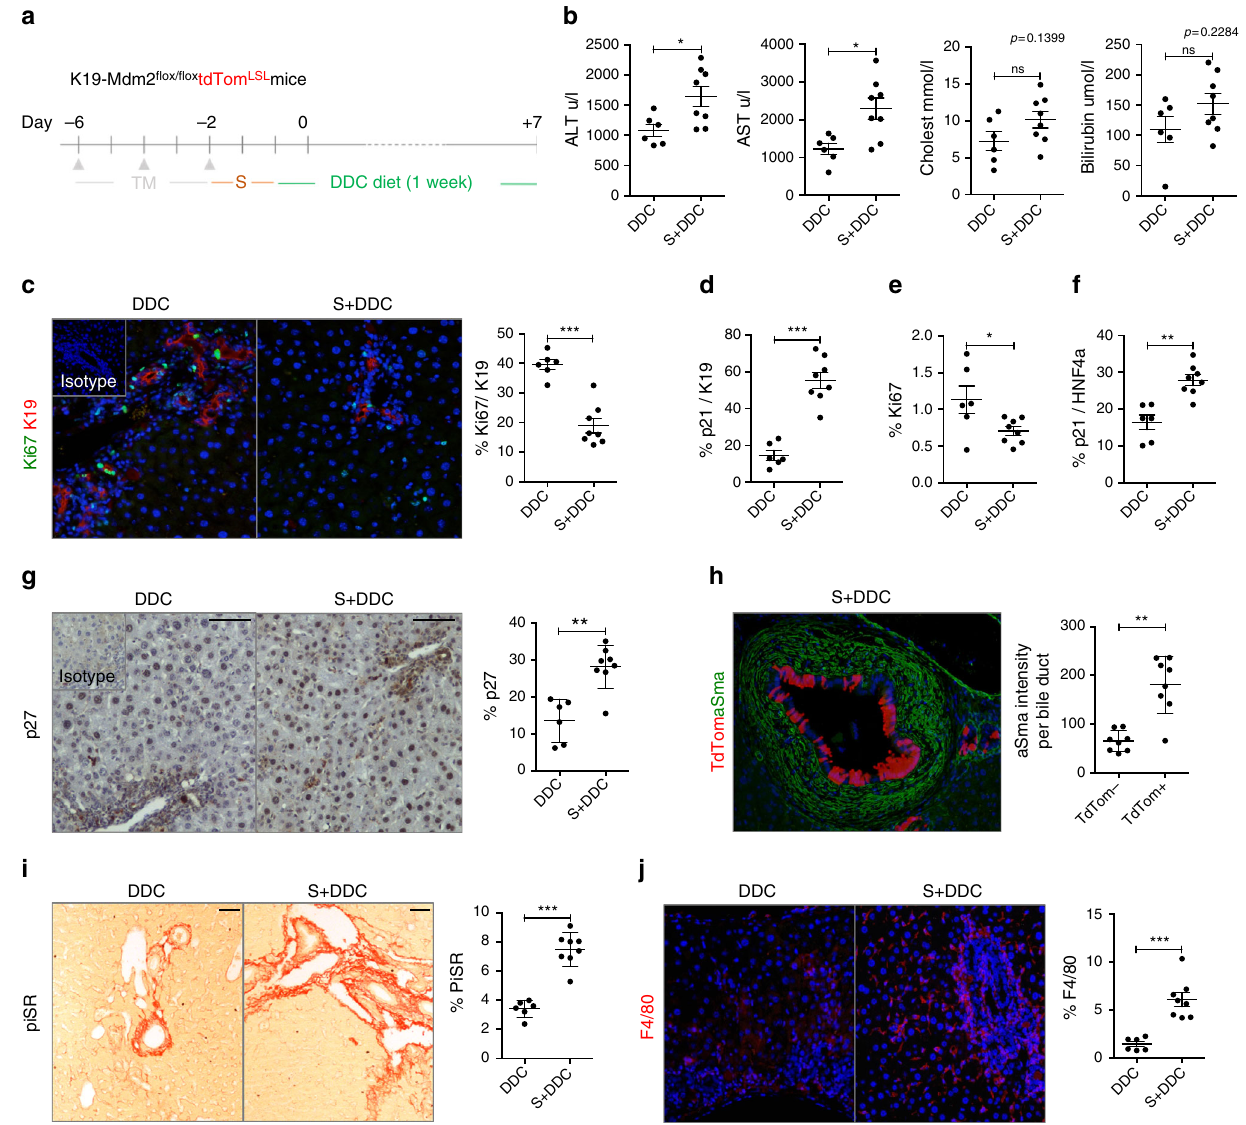
Fig. 4 Cellular senescence in cholangiocytes aggravates biliary injury. a Schematic representation of the experiment. Two days after the induction of the model the DDC diet was administered for 1 week. Experimental groups include: DDC diet control group (DDC, where mice are administered with oil, N = 6) and Senescence + DDC diet (S + DDC, where animals receive tamoxifen, N = 8). b Serum analysis shows increased liver damage in the presence of senescent cholangiocytes. c Ki67-proliferating (green) cholangiocytes (red) decrease in the S + DDC group. d Increased number of p21-positive cholangiocytes in the S + DDC group. e Total percentage of proliferating cells decrease in the S + DDC group. f Increased number of p21-positive HNF4 α - positive hepatocytes in the S + DDC group. g Increase of total number of p27 cells in the S + DDC group. h Increased presence of α SMA-positive cells (green) in the proximity of tdTom-positive senescent cholangiocytes (red). i Increased collagen deposition in the S + DDC group. j Increased number of F4/80-positive macrophages (red) in the S + DDC group. * denotes p < 0.05, ** p < 0.01, *** p < 0.001. (Mean ± SEM), Student ’ s t test. Scale bars = 50 µ